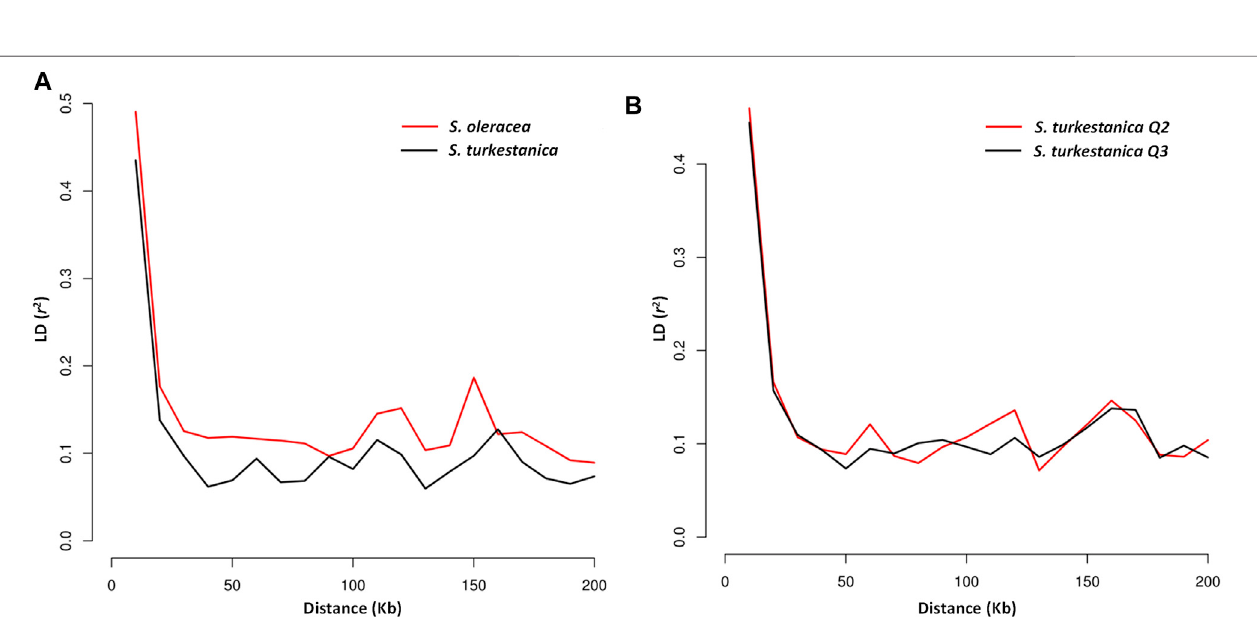
Frontiers in Genetics |